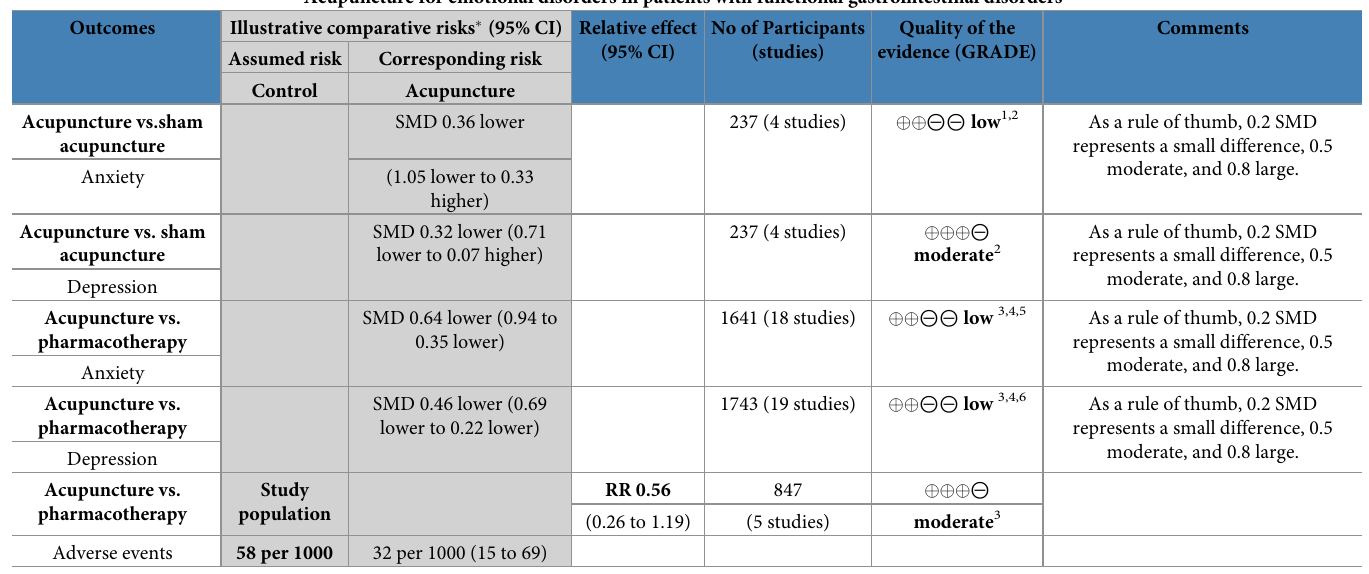
Table 2. Summary of